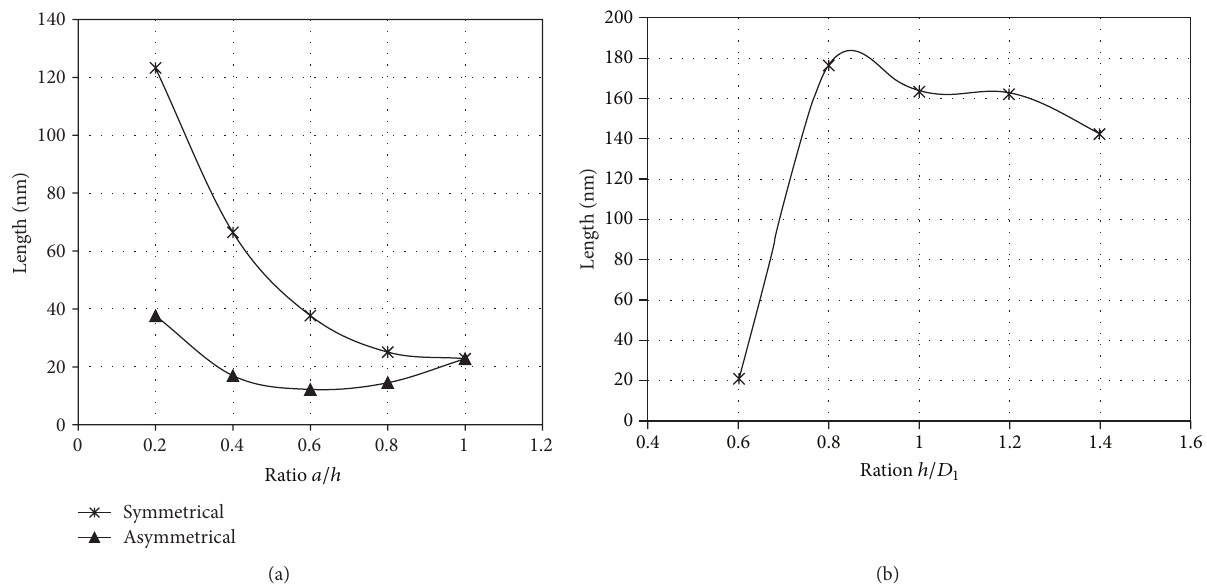
Figure 8: The dependence of the length of ellipses major semiaxis on thickness ratio of the ring type waveguide (a); height of the cone (b).